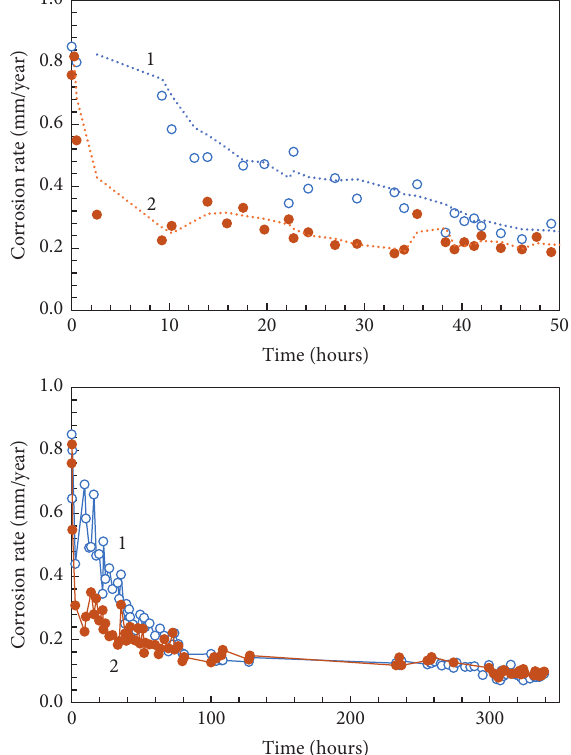
Figure 5: LPR corrosion rate of mild steel in tap water at 100 ° C: 1, blank; 2, with 10mL/L radish cake